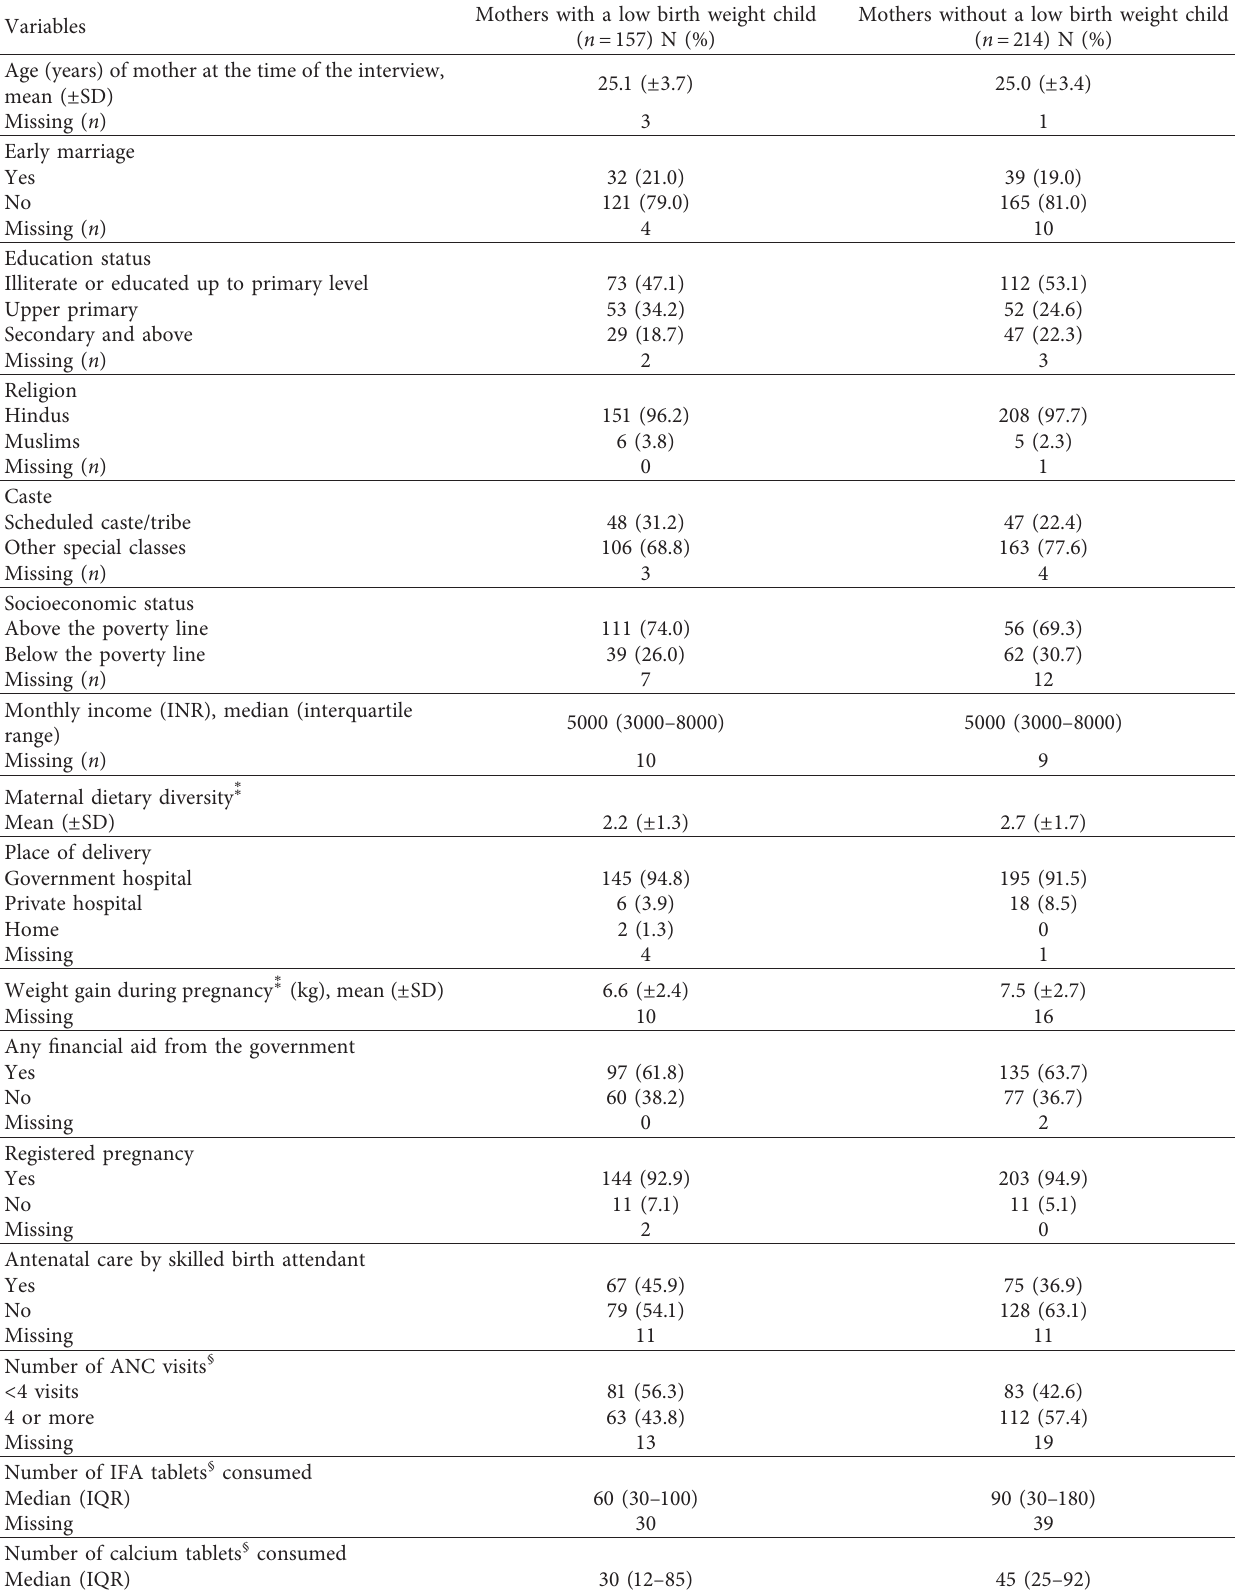
Table 1: Sociodemographic characteristics, maternal dietary diversity, and antenatal history of mothers with and without low birth weight